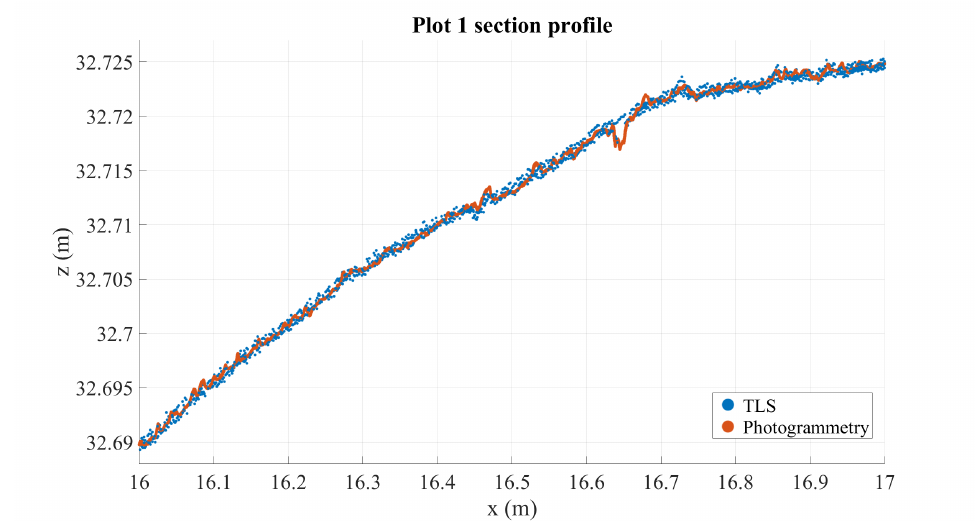
Figure 5. A section of the road profile from plot 1 showing Nikon and TLS point clouds. Photogram- metric data is 1 mm deep, while TLS data is 3 mm deep for visual clarity.